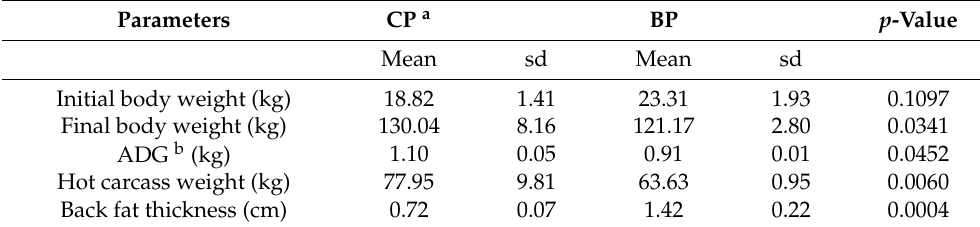
Table 2. Effect of breeds on the carcass characteristics.